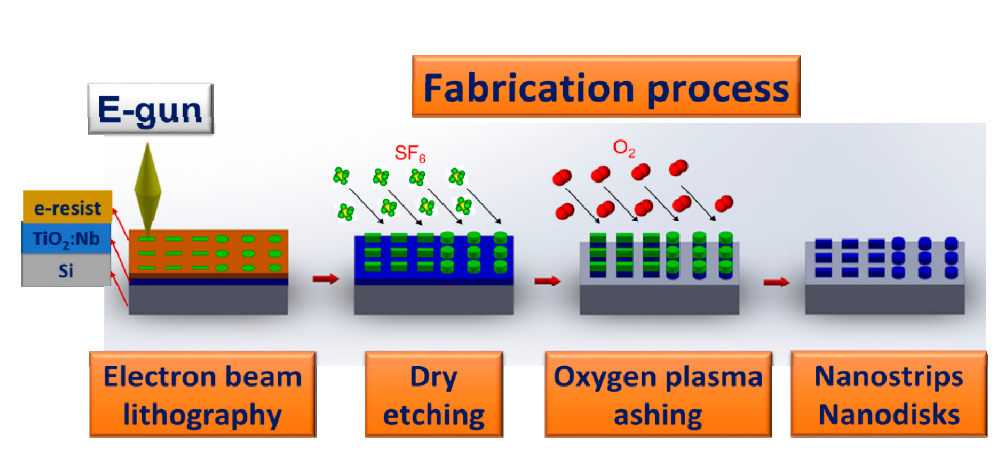
Figure 1. Fabrication process of Nb-doped TiO 2 nanoantenna (from left to right) consists of electron beam lithography, development, dry etching with SF 6 gas, and oxygen plasma ashing. The electron resist layer ( brown ) was coated on TiO 2 :Nb thin film ( blue ), which was deposited on silicon substrate ( grey ). The remained electron resist layer ( green ) after lithography process helped to define the nanostrip and nanodisk of antenna structures.